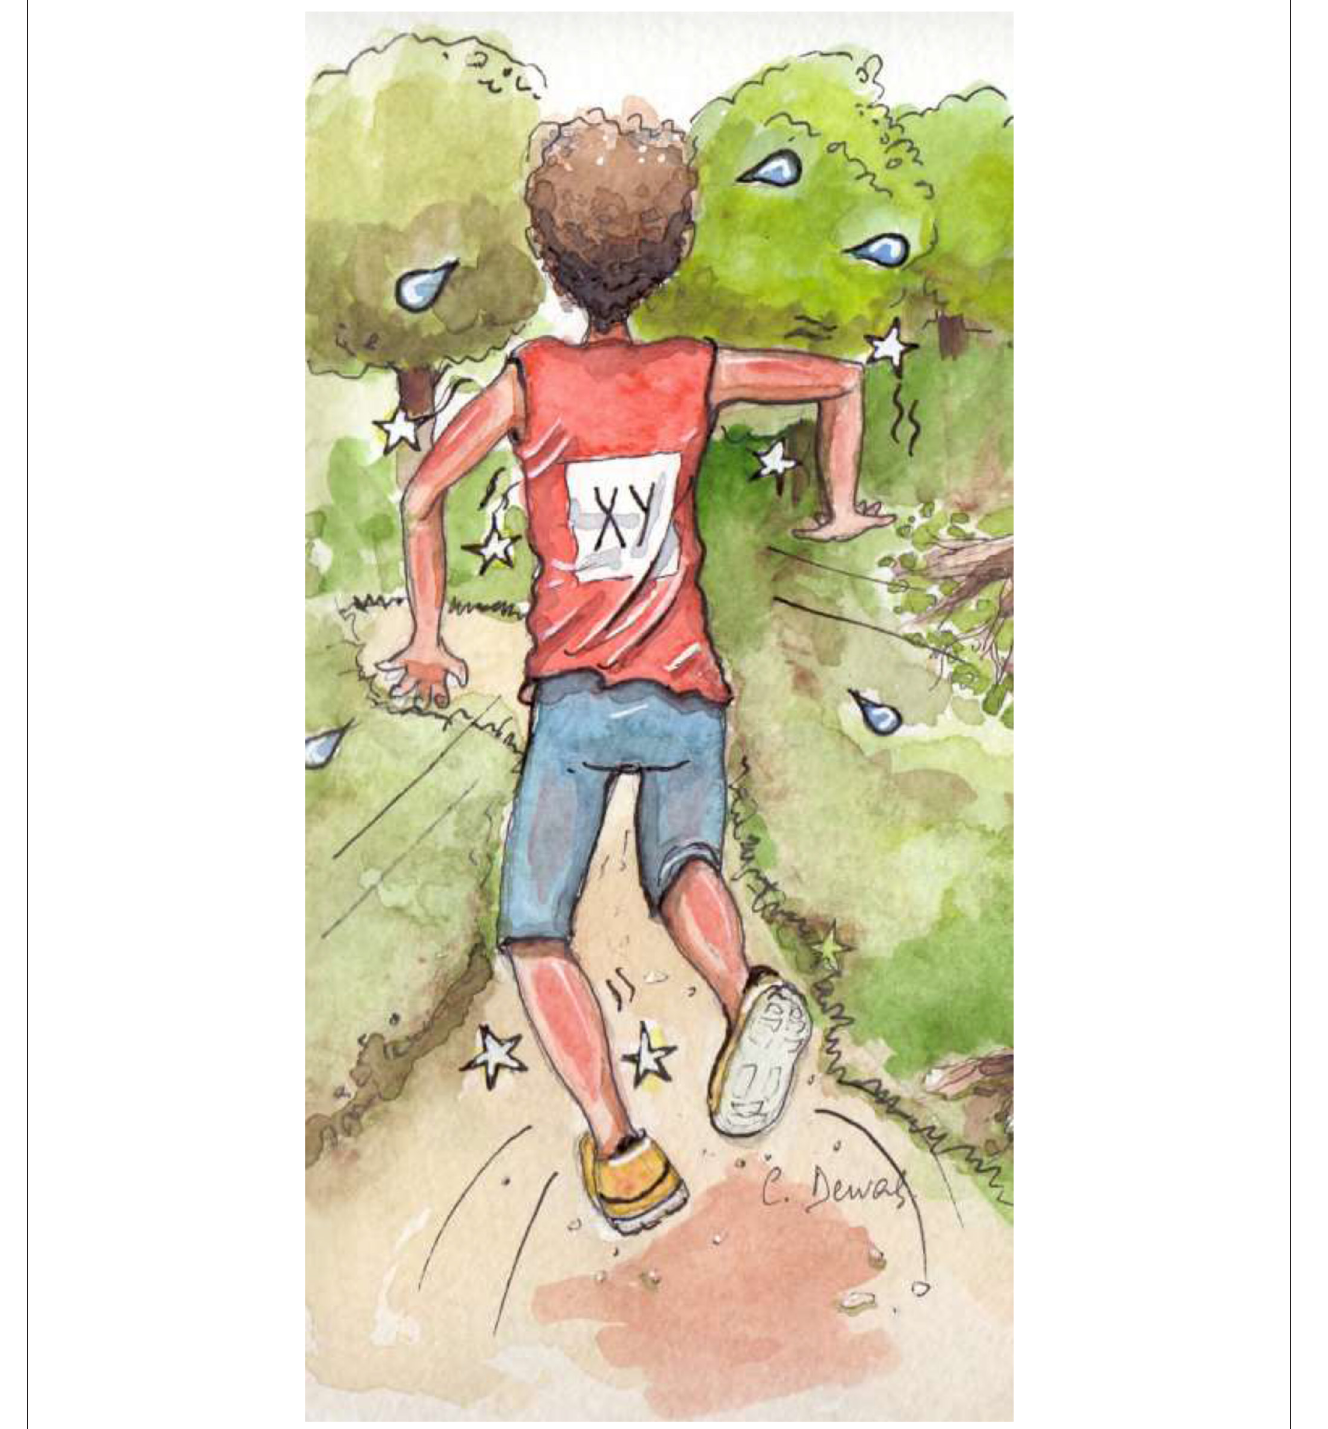
FIGURE 4 | Muscle pain can accompany muscle damage occurring during an ultra-marathon. Figure by Céline Dewas.